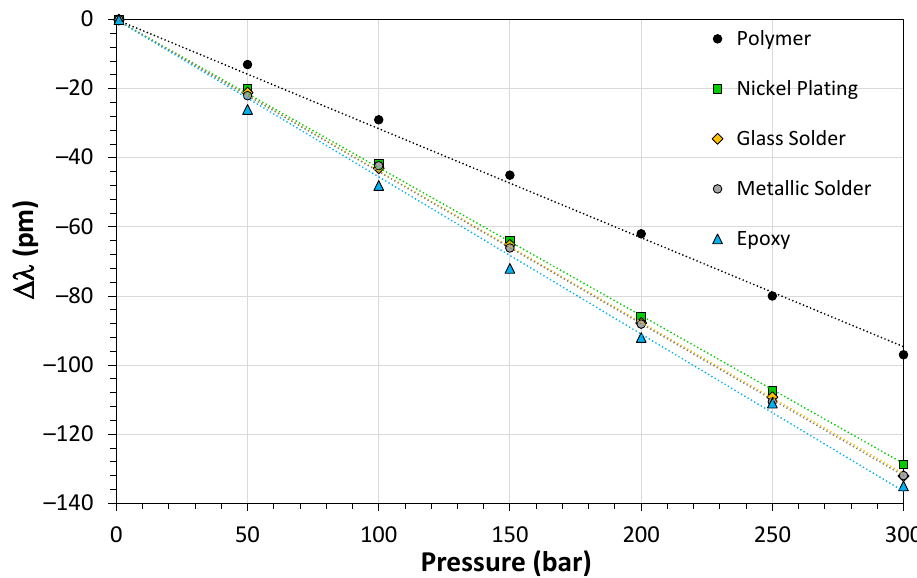
Figure 13. Results for the sensors that were approved in the leakage test.